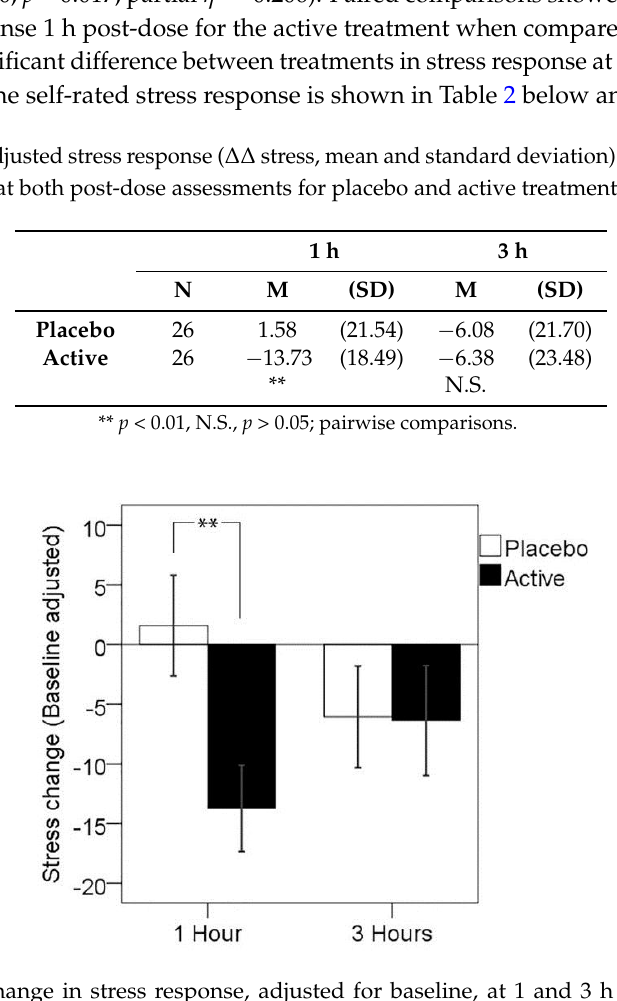
Figure 1. Mean change in stress response, adjusted for baseline, at 1 and 3 h post-dose for each treatment visit. Error bars ± 1 SE; ** p < 0.01. treatment visit. Error bars ˘ 1 SE; ** p <